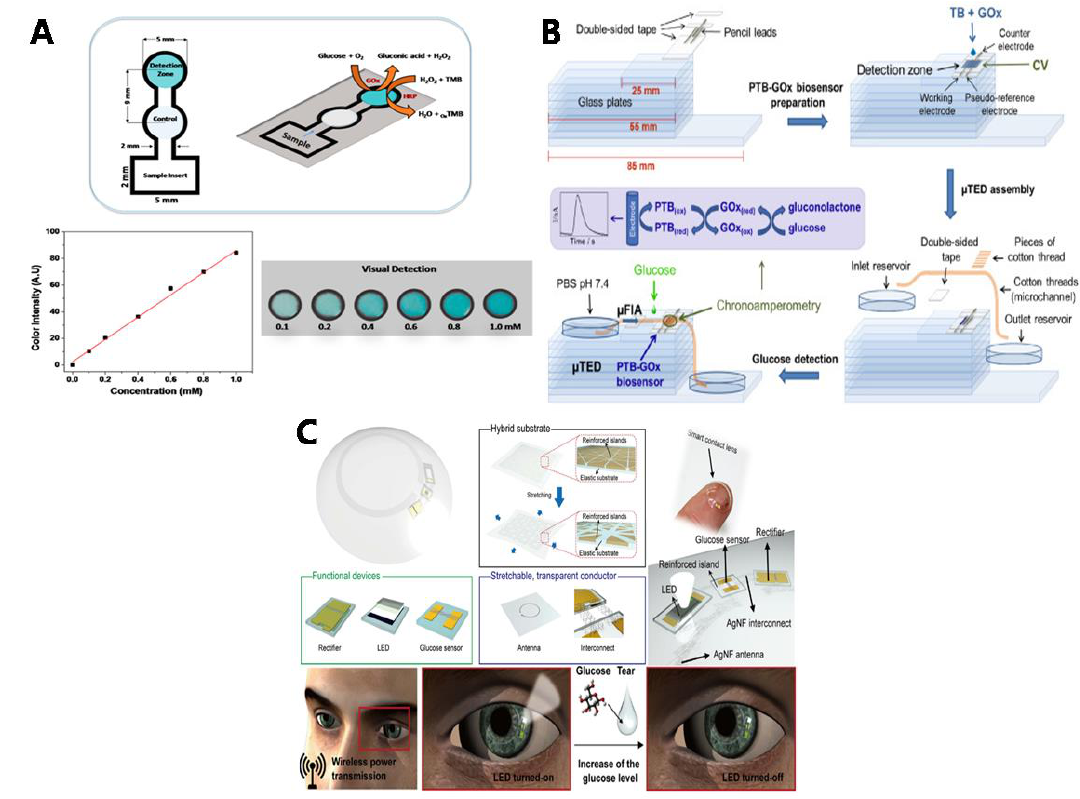
Figure 10. Tear-based glucose monitoring. ( A ) Paper-based colorimetric biosensor for tear glucose measurements. Adapted with permission [131]. Copyright 2017, Micromachines. ( B ) Tear glucose detection combining microfluidic thread based device, amperometric biosensor and microflow injection analysis. Adapted with permission [109]. Copyright 2017, Elsevier. ( C ) Soft, smart contact lenses with integrations of wireless circuits, glucose sensors, and displays. Adapted with permission